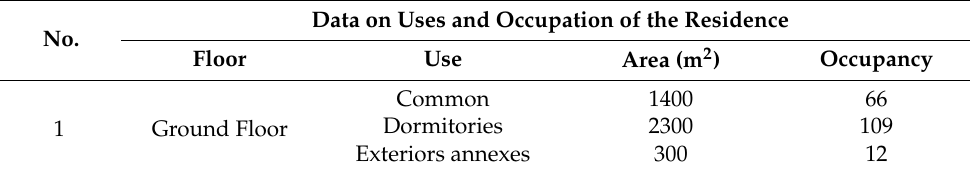
Table 2. Data on uses and occupation of the residence based on legal